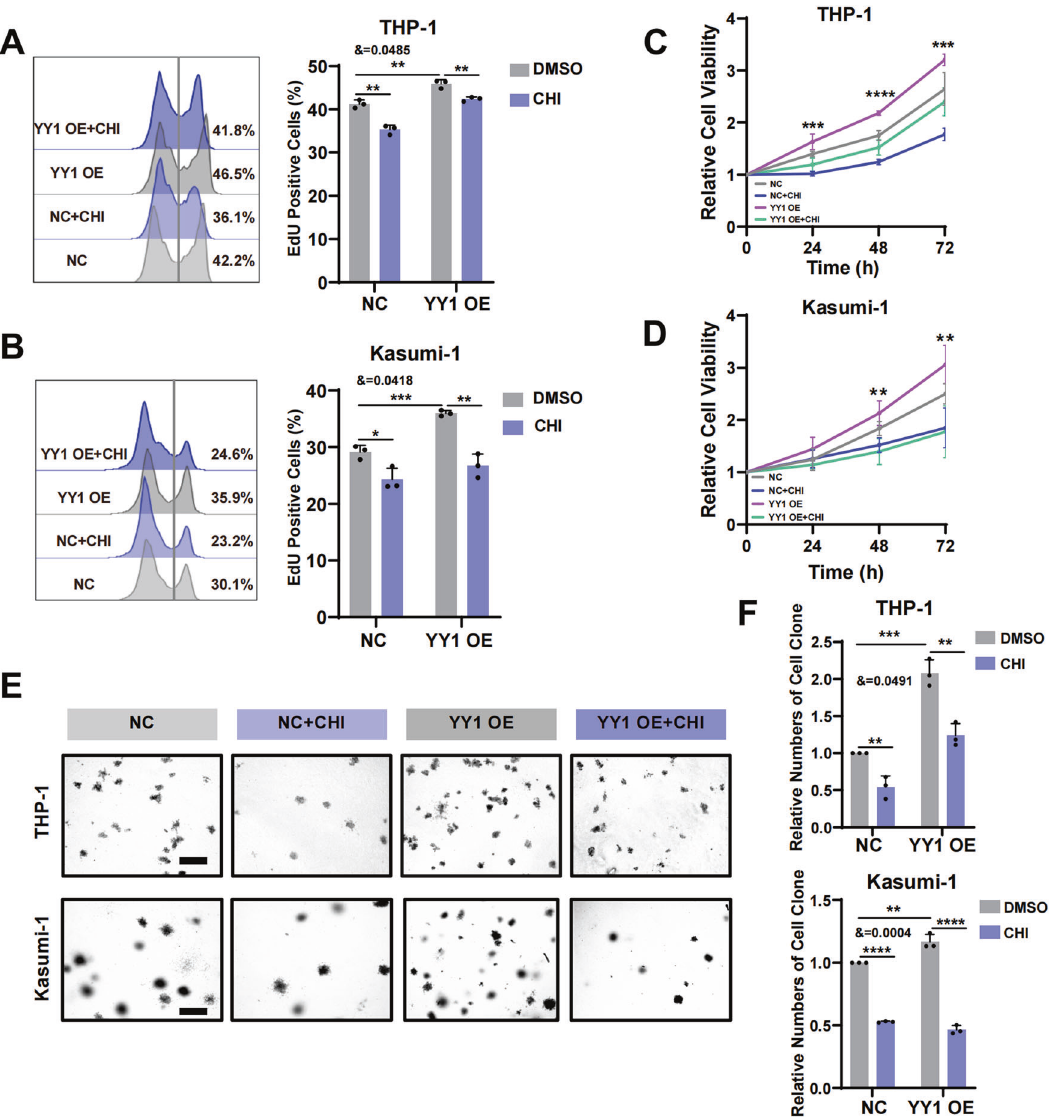
Fig. 4 HDACi inhibits AML cells proliferation through METTL3. A , B The proliferative activity of THP-1 cells ( A ) and Kasumi-1 cells ( B ) with or without 4 μ M CHI treatment for 24 h measured by fl ow cytometry EdU assay. * P < 0.05; ** P < 0.01; *** P < 0.001, t -test. & = interaction effect, two-way ANOVA. C , D The proliferative activity of THP-1 cells ( C ) and Kasumi-1 cells ( D ) measured by CCK-8 assay. ** P < 0.01; *** P < 0.001; **** P < 0.0001, one-way ANOVA. E The number of cell clone formed assessed by colony formation assay. Scale bars, 500 μ m. F Statistical chart of colony formation experiment. ** P < 0.01; *** P < 0.001; **** P < 0.0001, & = interaction effect, two-way ANOVA. (Fig. 4C, D). The colony formation experiment showed the same result (Fig. 4E, F). In conclusion, CHI can inhibit the proliferation of AML cells by regulating YY1. Cell Death and Disease (2022)